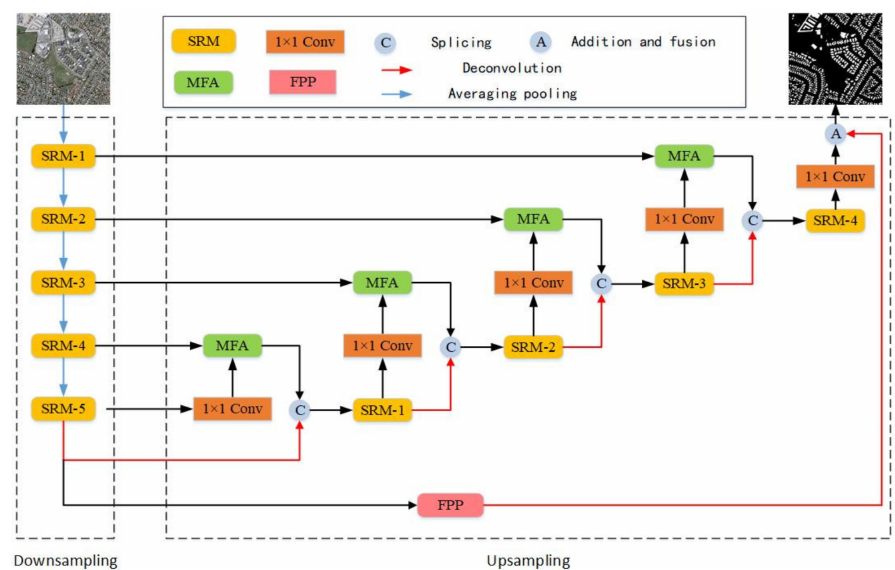
Figure 1. FRA-Net model